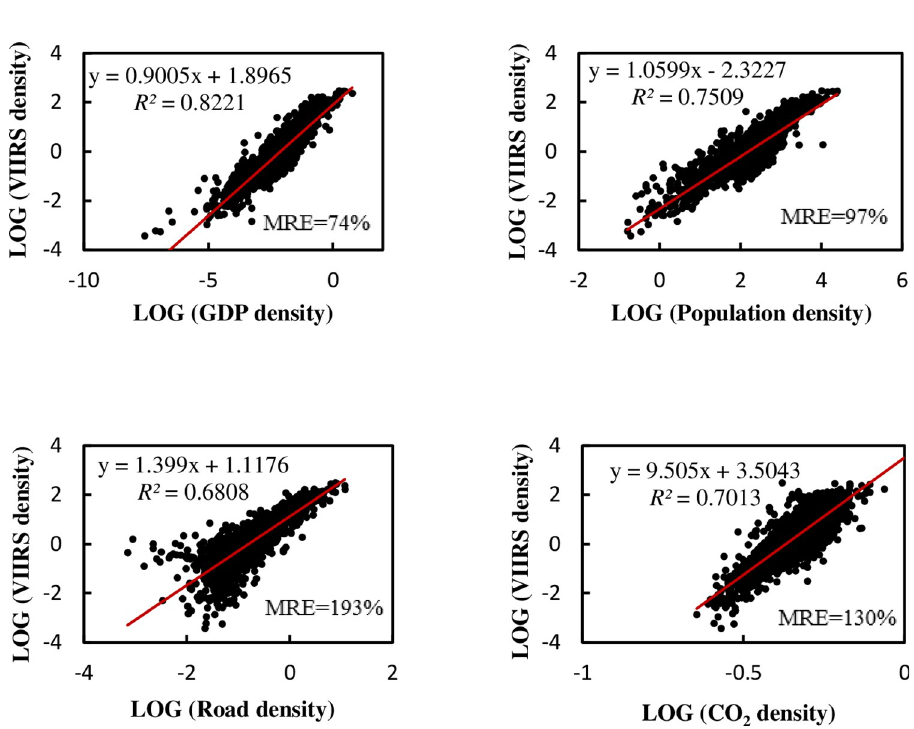
Fig 11. Relationship between double logarithmic NTL density and density of various elements in county-level administrative regions of China.